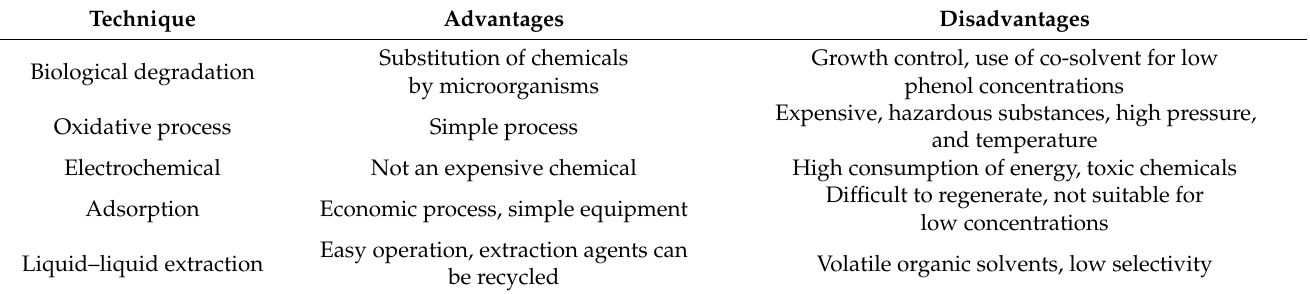
Table 2. Advantages and disadvantages of techniques used to remove phenolic compounds from water